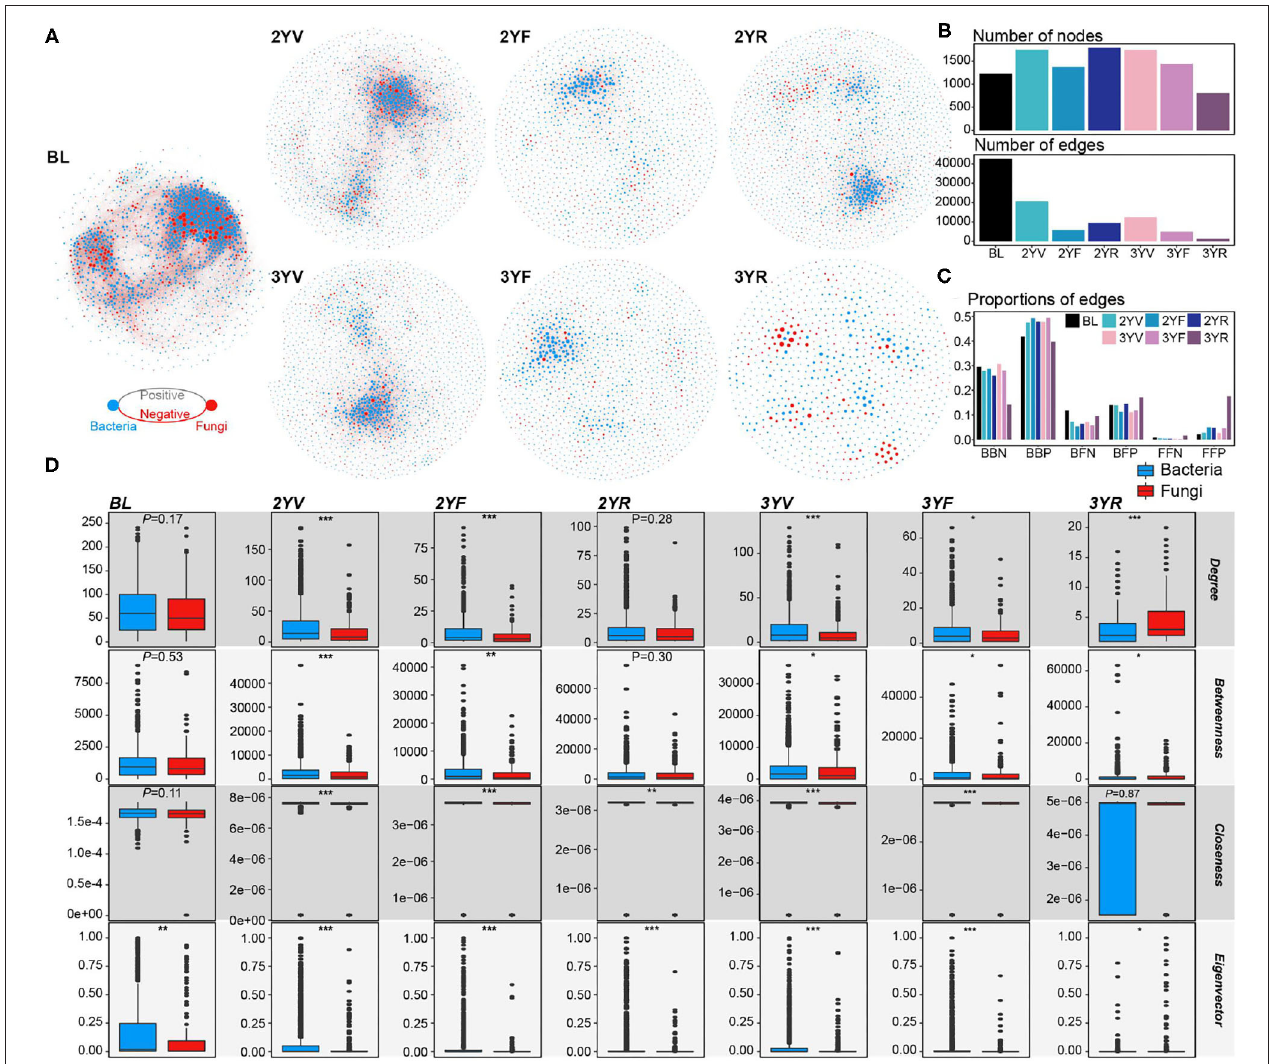
FIGURE 3 | Cross-domain networks and node-level topological properties. (A) Cross-domain networks are constructed from each developmental stage. Blue and red nodes represent bacterial and fungal nodes, respectively. Gray and red edges represent positive and negative correlations among nodes, respectively. (B) The number of nodes and edges in each cross-domain network. (C) The proportion of the different types of edges in each cross-domain network. (D) Node-level topological properties of bacterial and fungal nodes in each cross-domain network. *, P < 0.05; **, P < 0.01; ***, P <